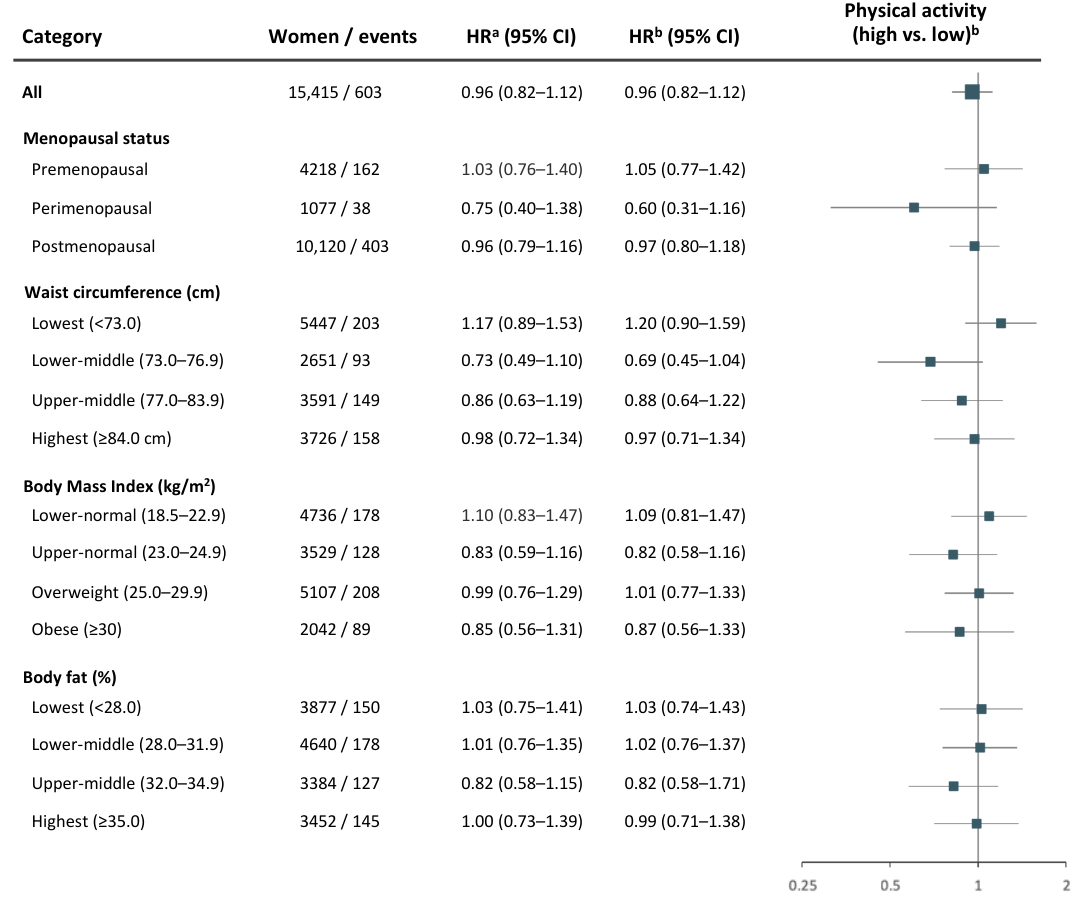
Figure 4. Physical activity and short-term (0 – 11 years) risk of breast cancer. Age- and multivariable- adjusted hazard ratios (HR) with 95% CI for a high versus low level of physical activity among all women, and by menopausal status or body composition. Women and breast cancer events shown represent the numbers available in the multivariable model. The forest plot illustrates multivariable- adjusted HR with 95% CI. a Model adjusted for age at baseline. b Multivariable model adjusted for age at baseline, age at menarche, parity, age at first childbirth, oral contraceptive use, current hormone replacement therapy use, socioeconomic index, and alcohol consumption. Models for all women or stratified by body composition (waist circumference, BMI, or body fat percentage) were additionally adjusted for age at menopause.